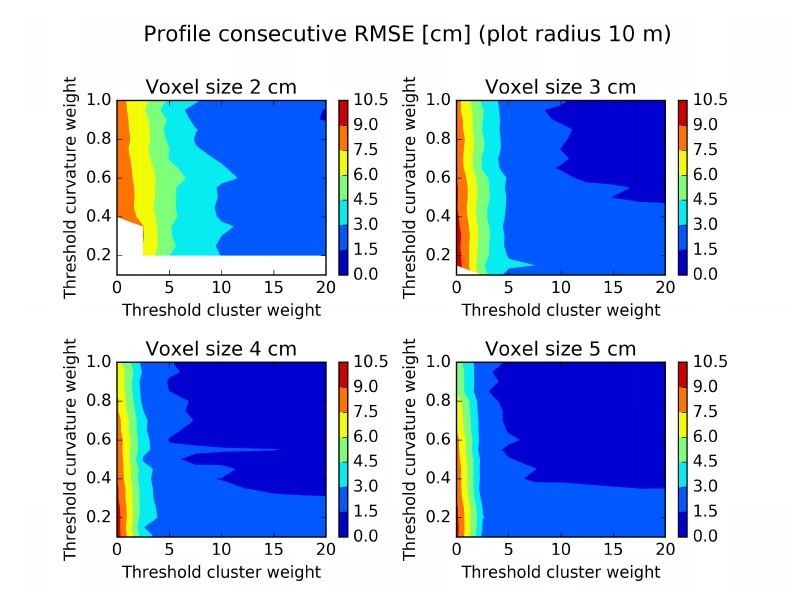
Figure 10. Profile consecutive diameter RMSE evaluated on a plot of a radius of 10 m and different parameter settings. White areas indicate missing data. High parameter threshold values give smooth stem profiles.